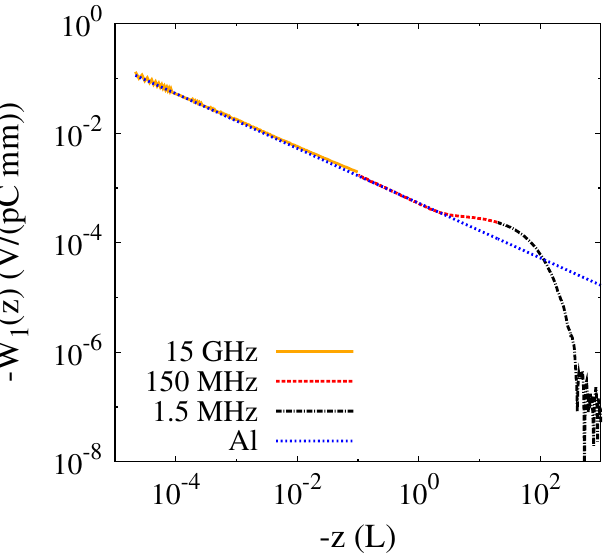
FIG. 1. (Color) The wake function for a beam pipe of radius 3 cm, wall thickness 2 mm, and beam radius 3 mm. The dotted blue straight line is the high-frequency limit obtained from Eq. (2). The curve is finite wall wake function, patched together from the FFT results of three frequency ranges. ( L is the circum- ference of the